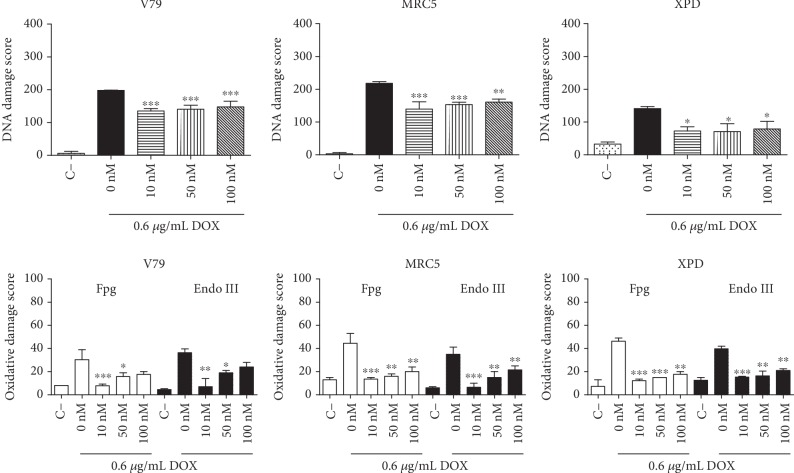
Antigenotoxic effects of 2 h DPDT pretreatment in serum-free medium on the genotoxicity of doxorubicin in Chinese hamster fibroblasts (V79) and human fibroblasts proficient (MRC5) and deficient (XPD) in NER, evaluated by comet assay and modified comet assay. Data are reported as means ± SD of three independent experiments. Significantly different at ∗p < 0.05, ∗∗p < 0.01, and ∗∗∗p < 0.001 compared with cells treated with doxorubicin only (one-way ANOVA followed by Tukey test). The damage index is an arbitrary score calculated from cells in different damage classes, which are classified by visual evaluation of the DNA migration length and the amount of DNA in the comet tail. The oxidative damage score represents the difference in the damage scores between cells incubated with the Fpg and Endo III enzymes and the cells incubated with the incubation buffer only.